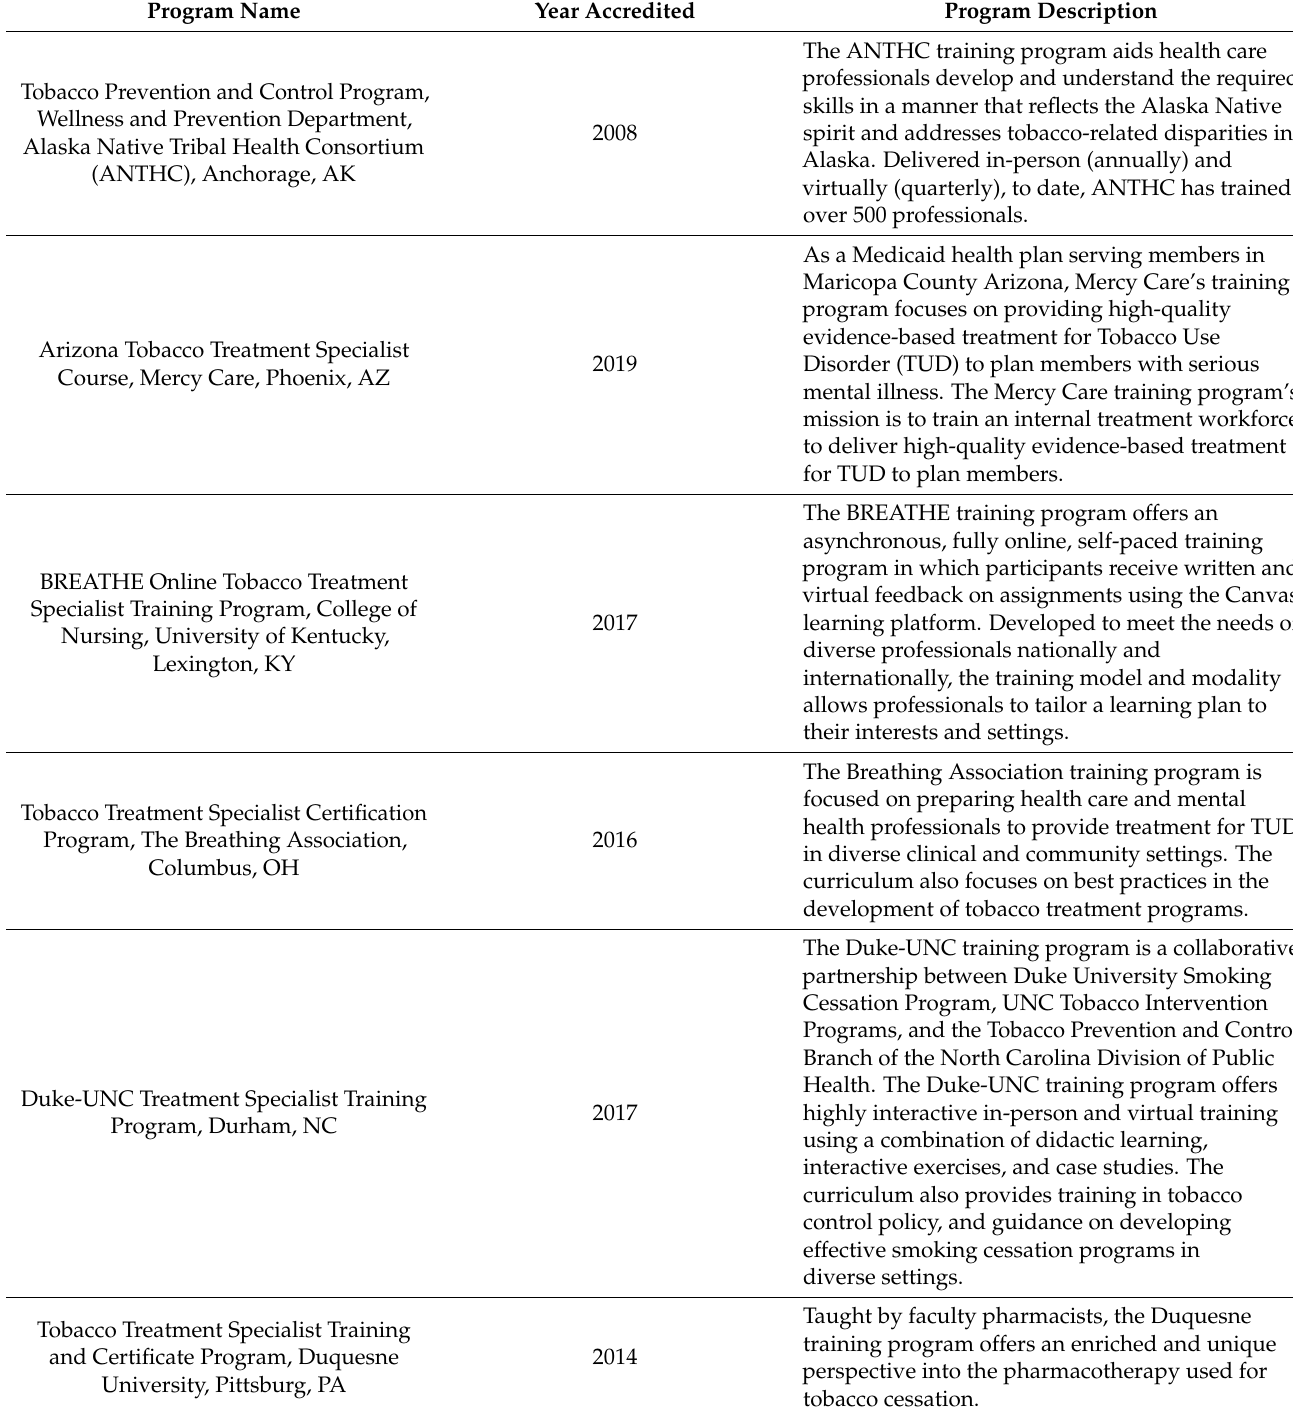
Table 3. Tobacco Treatment Training Programs Accredited by the Council for Tobacco Treatment Training Programs